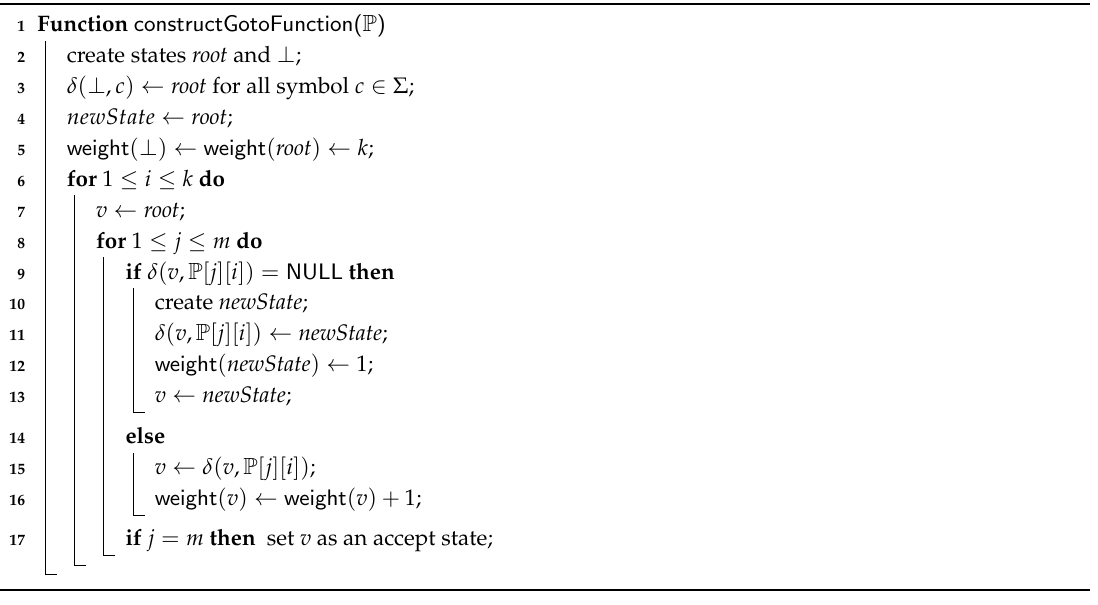
Algorithm 7: Multi-track permuted matching automaton goto function construction algorithm.